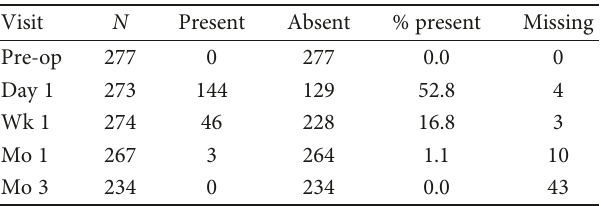
Table 8: Presence of hyphema by visit (all